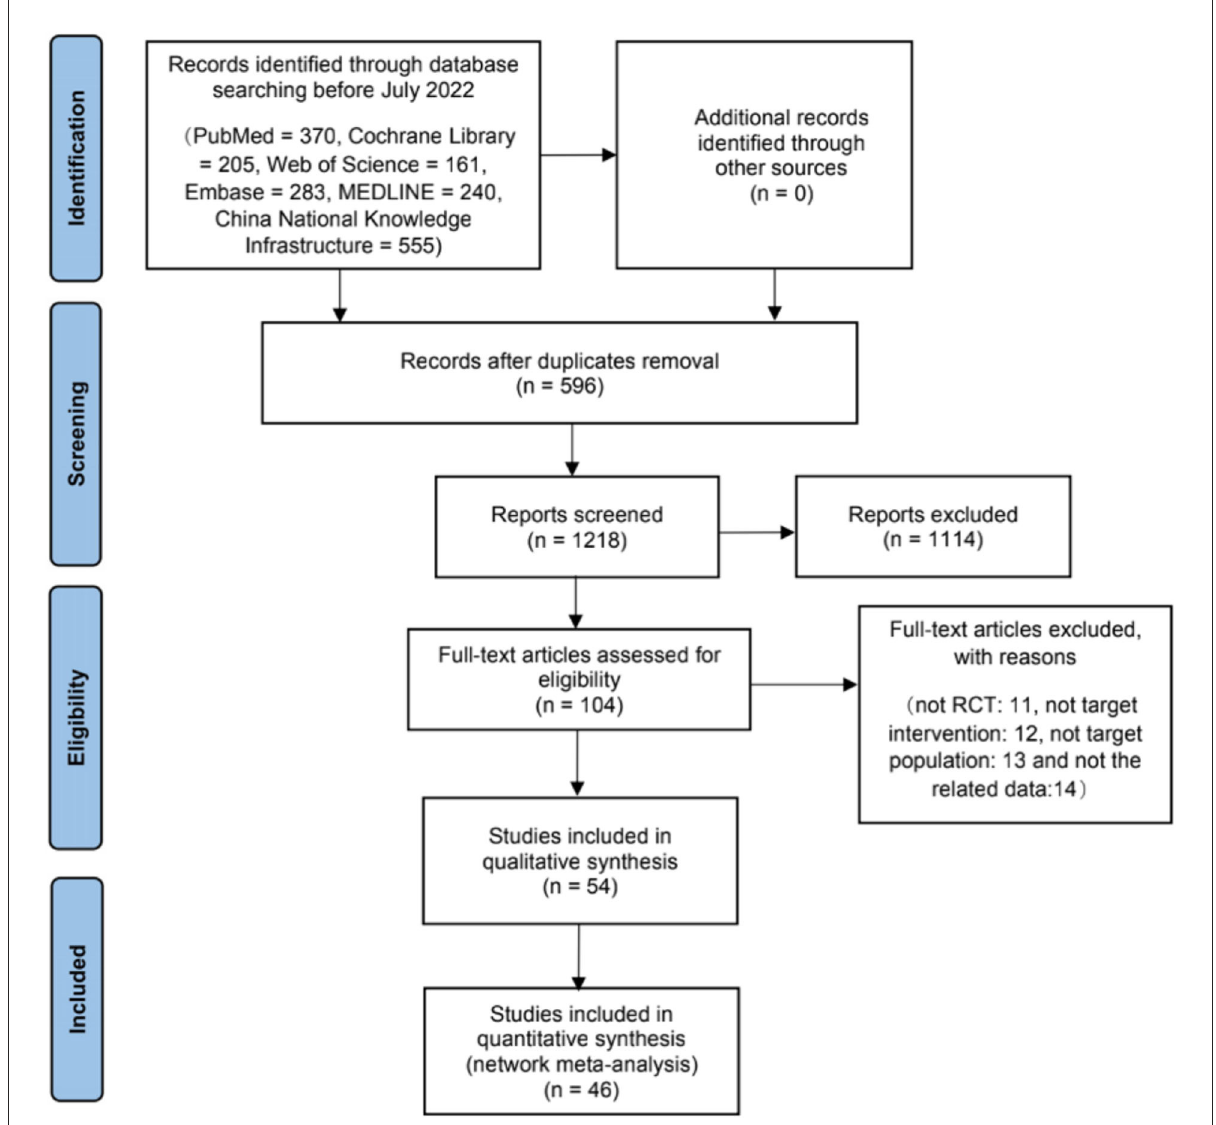
FIGURE1 Flowchart of literature selection on systematic reviews on acupuncture for treating vascular